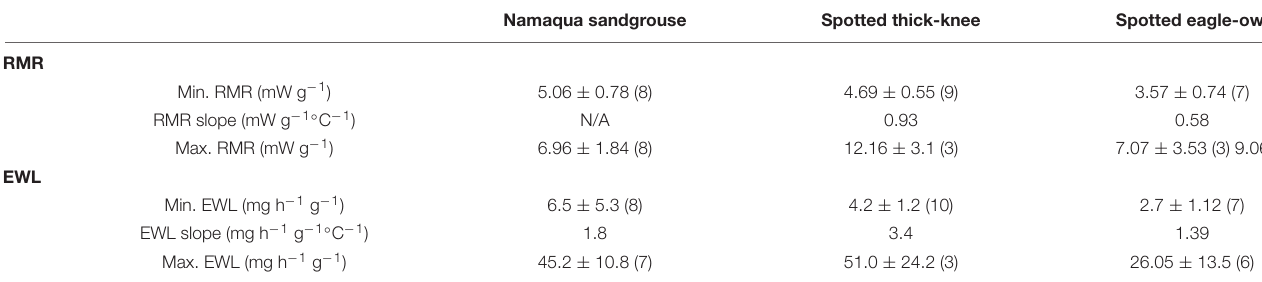
FIGURE 2 | Resting metabolic rate (RMR) showed a clear inflection (i.e., upper critical limit of thermoneutrality; T uc ) in spotted thick-knees ( Burhinus capensis ; top right) and spotted eagle-owls ( Bubo africanus ; lower left), but no inflection was evident for Namaqua sandgrouse ( Pterocles namaqua ; top left). Segmented linear regression models are shown for thick-knees and owls using solid lines, whereas the relationship between T air and RMR in sandgrouse was non-significant. Inflection T air values and slopes for relationships between T b and T air are provided in Table 2 . The lower right panel shows patterns for all three species for comparative purposes. Sources of the bird silhouettes are provided in the Figure 1 legend. TABLE 3 | Mass-specific resting metabolic rate (RMR) and evaporative water loss (EWL) at high air temperature in three species from the arid zone of southern African: Namaqua sandgrouse ( Pterocles namaqua ), spotted thick-knees ( Burhinus capensis ) and spotted eagle-owls ( Bubo africanus ). Namaqua sandgrouse Spotted thick-knee Spotted